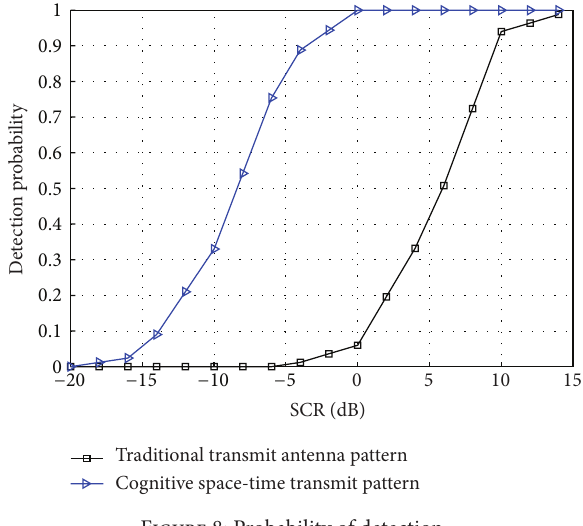
Figure 8: Probability of